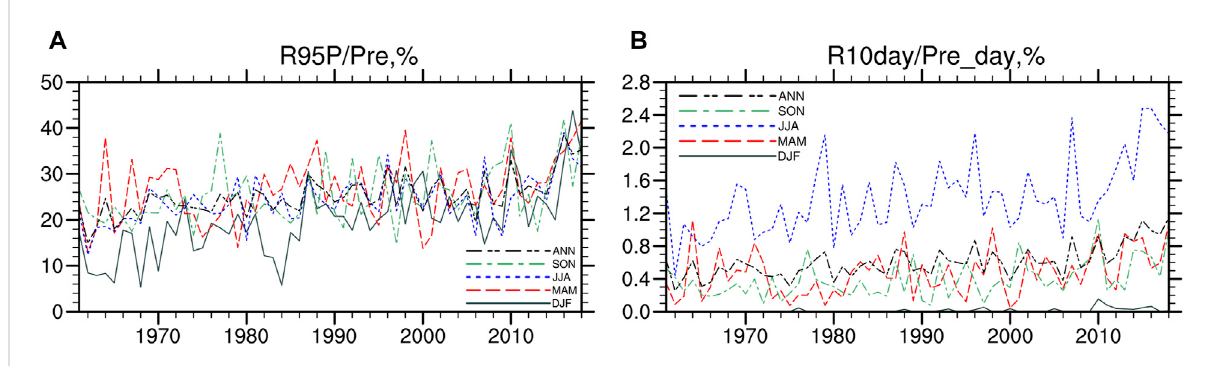
FIGURE 4 Variations in the ratio of R95P to total precipitation (A) and the ratio of R10day to total precipitation days (B) in the ANWC from 1961 to 2018.